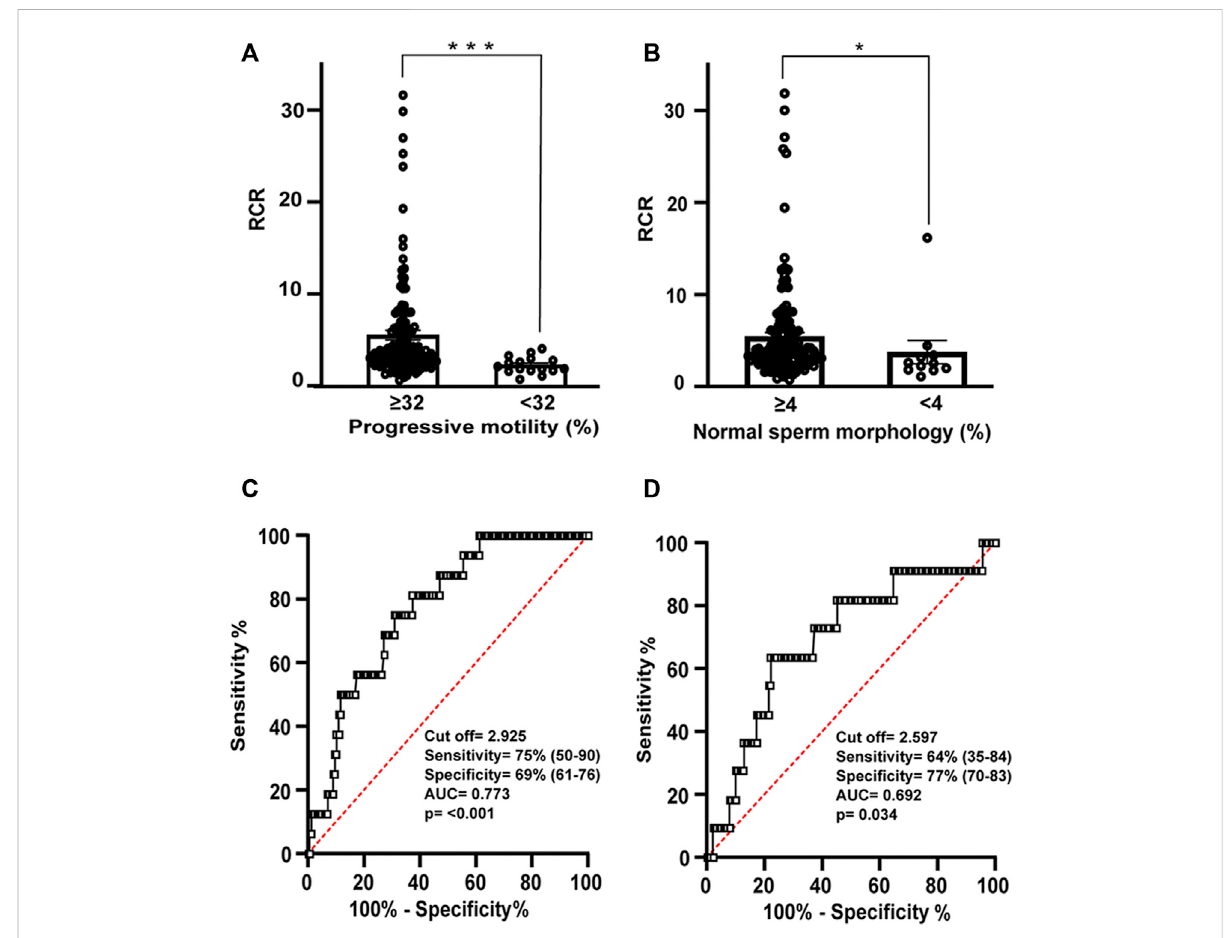
FIGURE 5 Relation between RCR, motility and morphology spermogram parameters. Bars represent means ± SEM of (A) progressive motility ( ≥ 32% N = 155; < 32% N = 16) and (B) normal sperm morphology ( ≥ 4% N = 150; < 4% N = 11). Mann-Whitney test was used to determine statistical signi fi cance; * p < 0.05,*** p < 0.001. (C) Receiveroperatingcharacteristic(ROC)curveshowingRCRcutoffvalue,sensitivity(%),speci fi city(%),andareaunderthe curve for samples with normal or abnormal percentage of progressive motility and (D) ROC curve showing RCR cut off value, sensitivity (%), speci fi city (%), and area under the curve for samples with normal or abnormal percentage of spermatozoa with normal